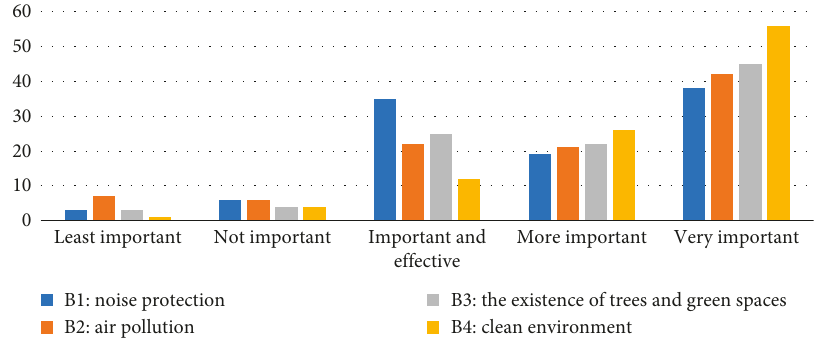
Figure 10: Evaluation of environmental factors.